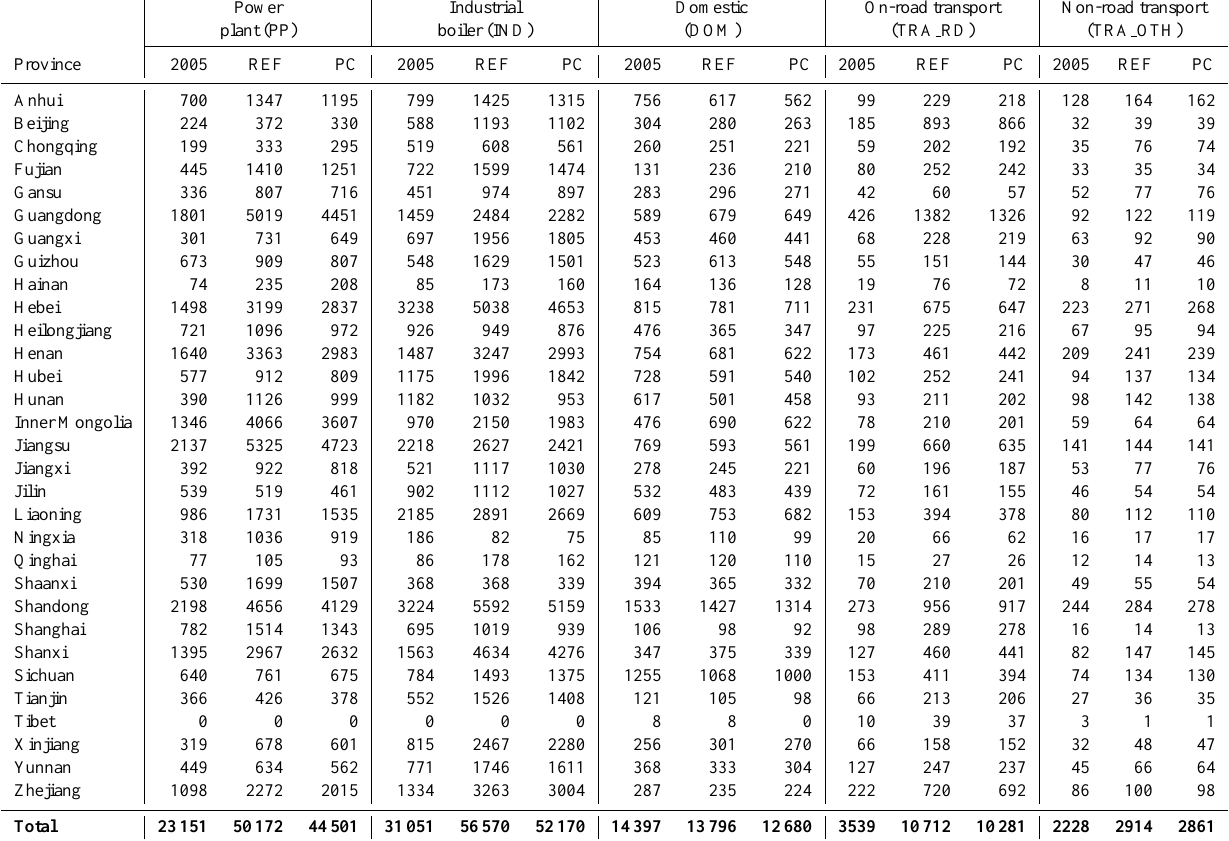
Table 2. Sectoral fuel use by each Province in 2005 and 2020 scenarios